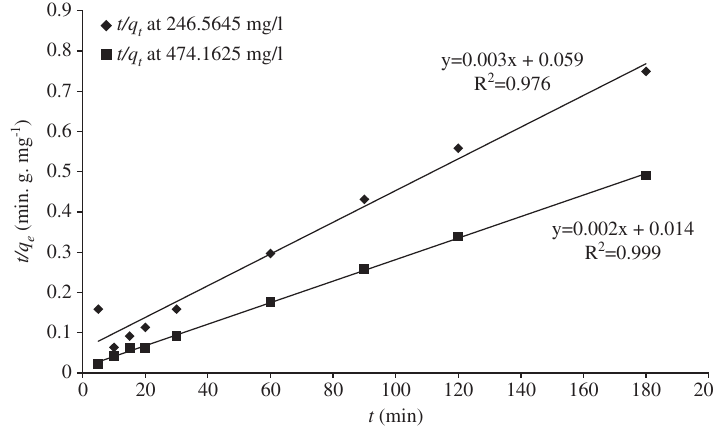
Figure 7: Pseudo-second order reaction of Pb(II) onto S. sesban L. at 30 ° C.